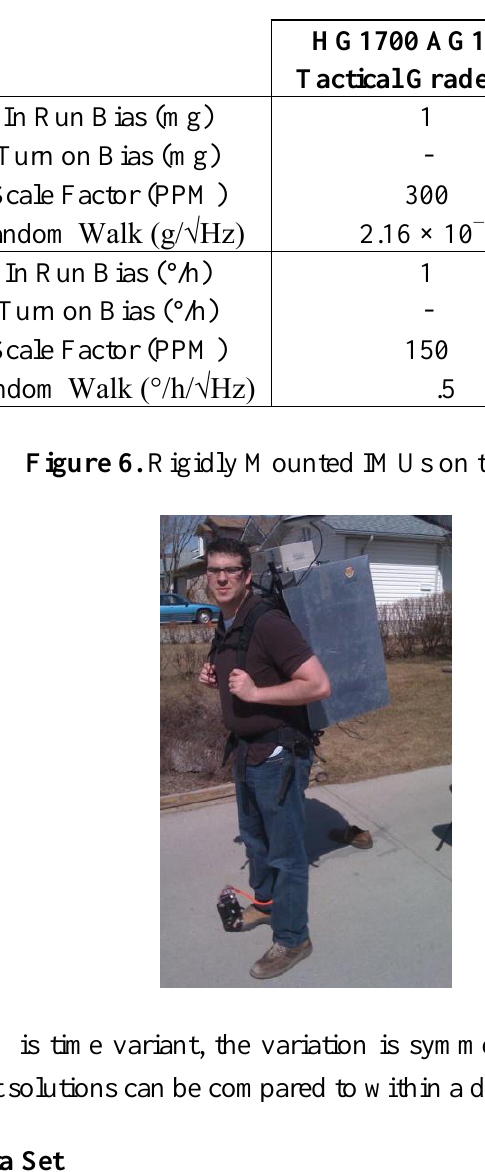
Table 2. Reference and MEMS Grade IMU Maximum Errors.